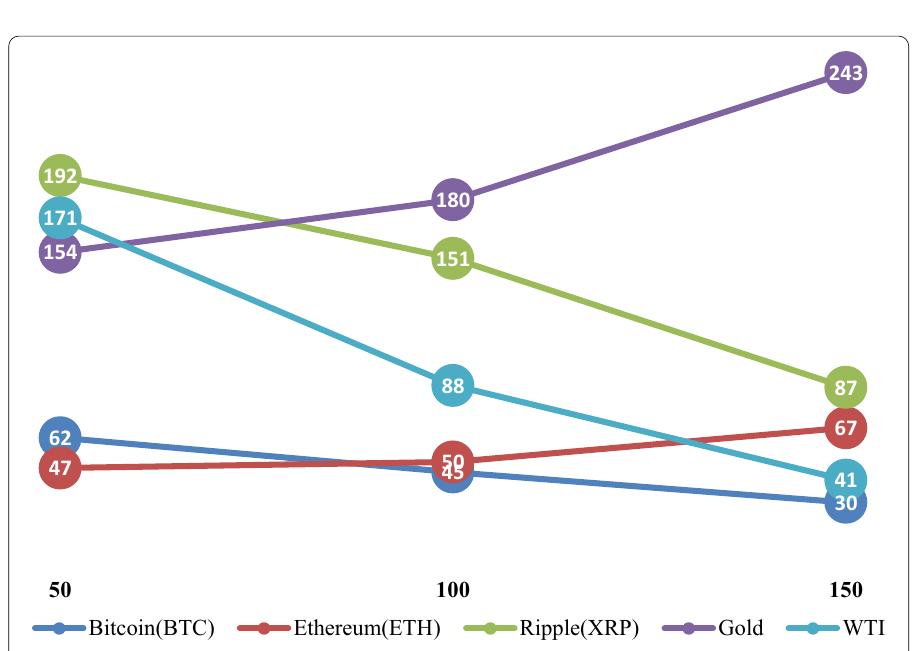
Fig. 2 Analyzing the behavior of market efficiency by AQ tests statistics at 10 percent significant